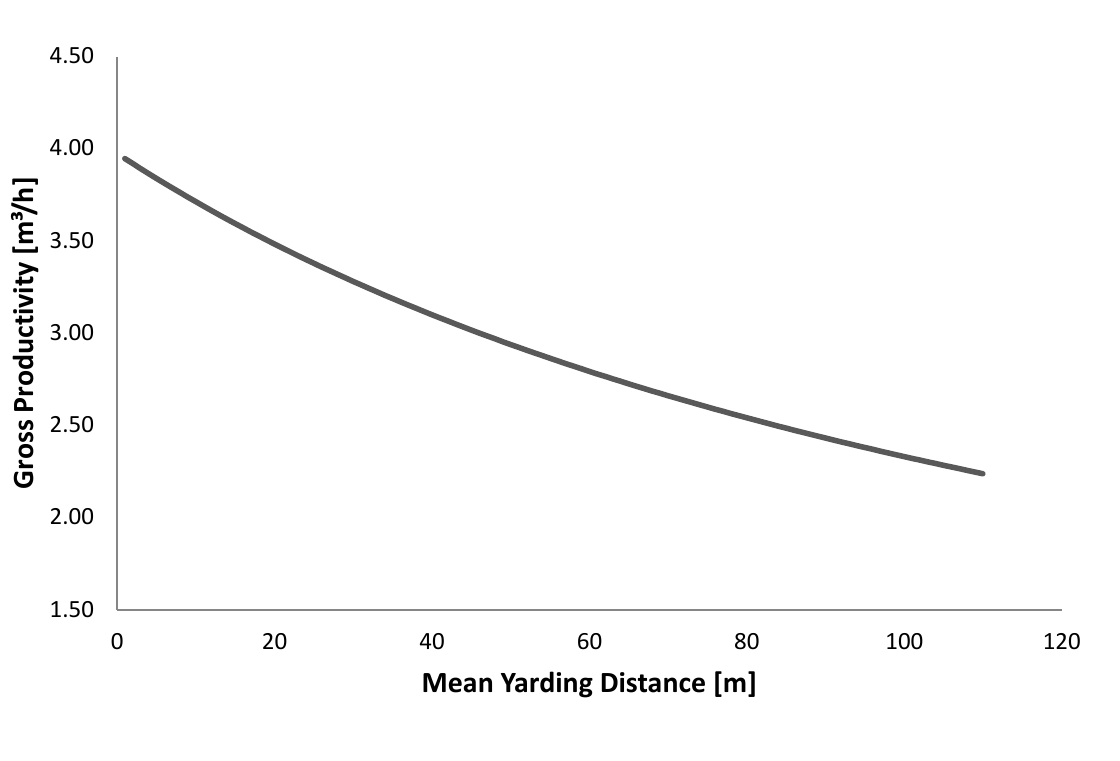
Figure 7 . Gross productivity of the Igland Hauler measured in yarded volume (m³) per hour as a function of mean yarding distance (m) based on the computed regression model (t cycle ) and the mean payload of the